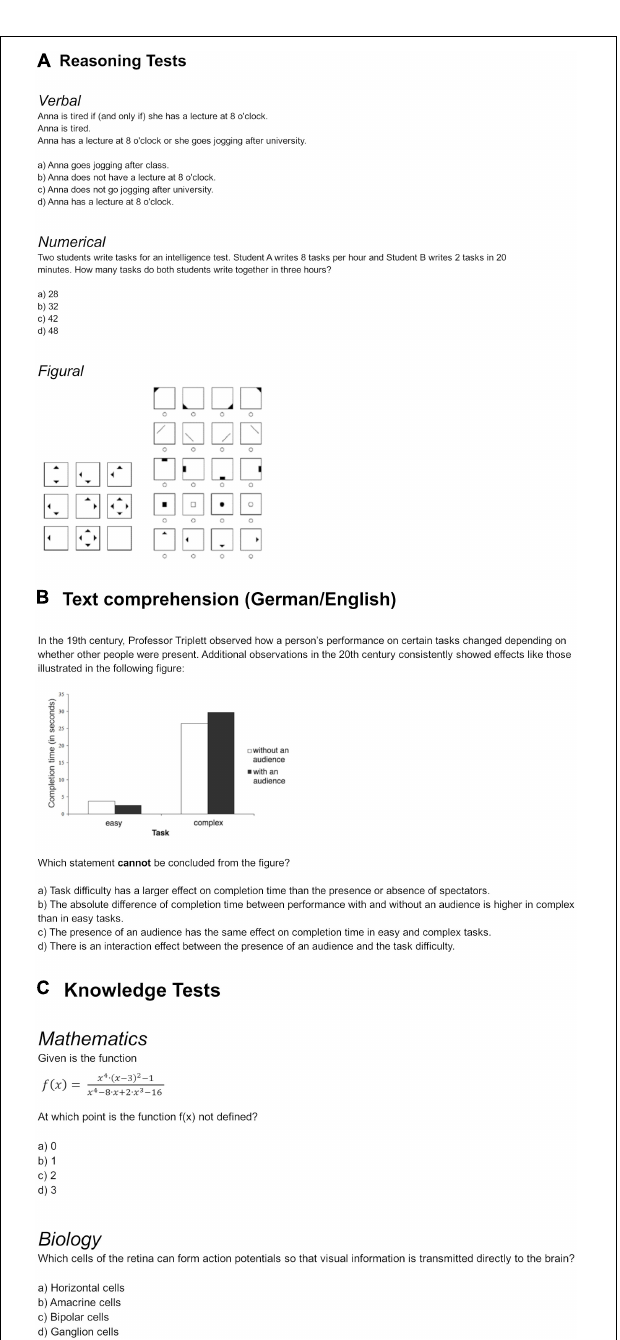
FIGURE 1 | Sample items of (A) verbal, numerical, and figural reasoning tests, (B) psychology-specific text comprehension tests, and (C) declarative knowledge